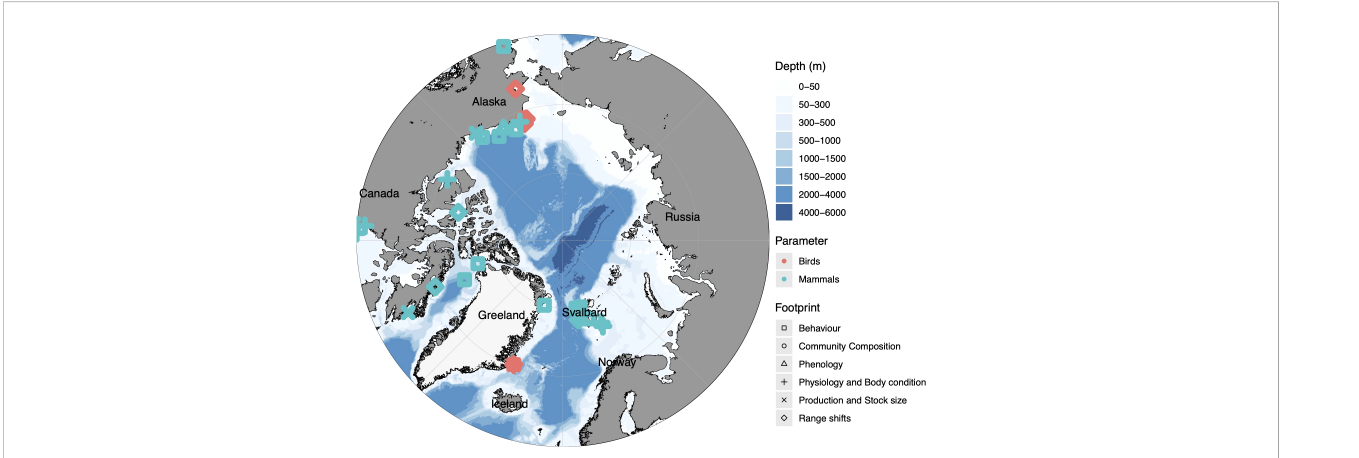
FIGURE 3 Map of the geographical distribution of primary footprints on a pan-Arctic scale Part 2 (Birds and Mammals). The colours present the different parameters, while the shape represent the type of footprint. Please note that the geographical North Pole was chosen as a representative point for all pan-arctic studies, therefore overlapping can occur. Further, not all footprints are represented in this plot, due to their geographical location. A summary of all relevant papers sorted by footprint types and parameters in Supplementary Tables